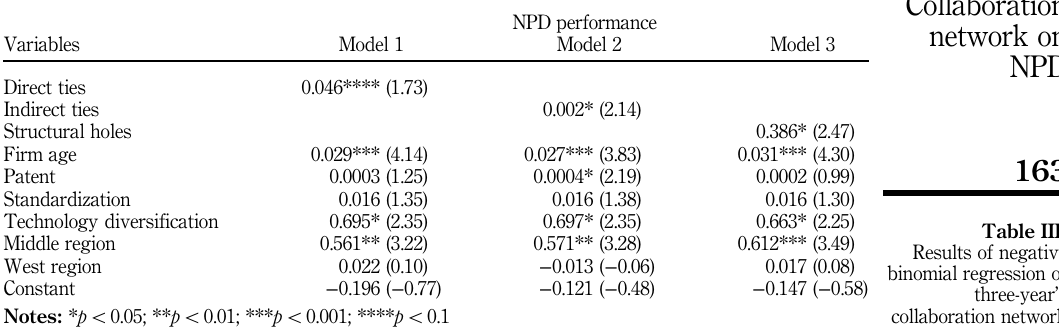
Table III. Results of negative binomial regression of three-year ’ s collaboration network